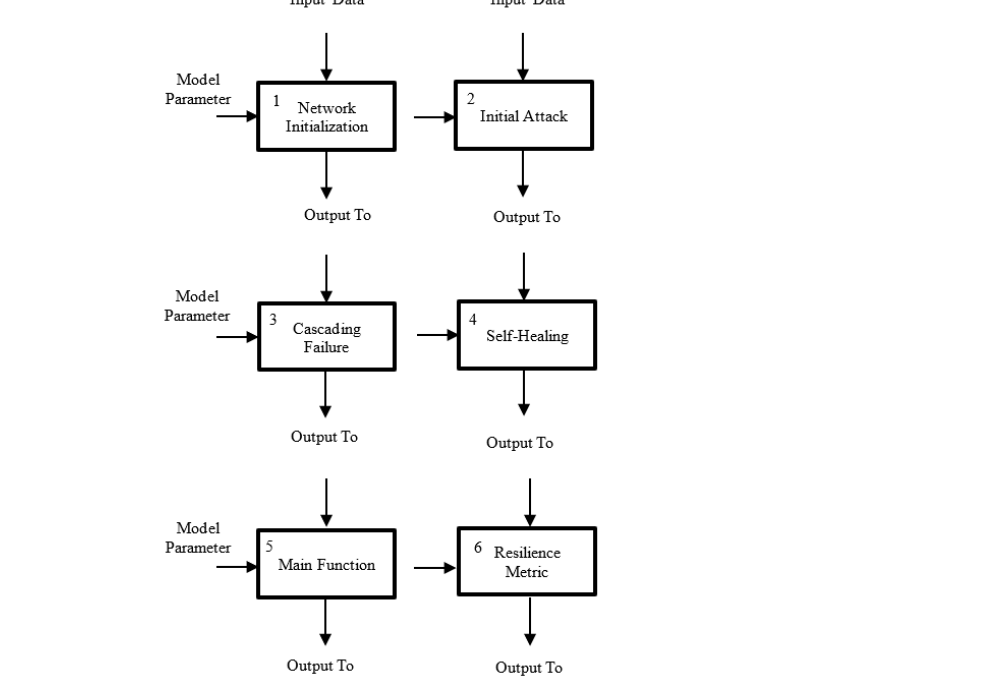
Figure 2. Modules involved in the simulation of the ESS-WH network load-based cascading failure and the healing process.